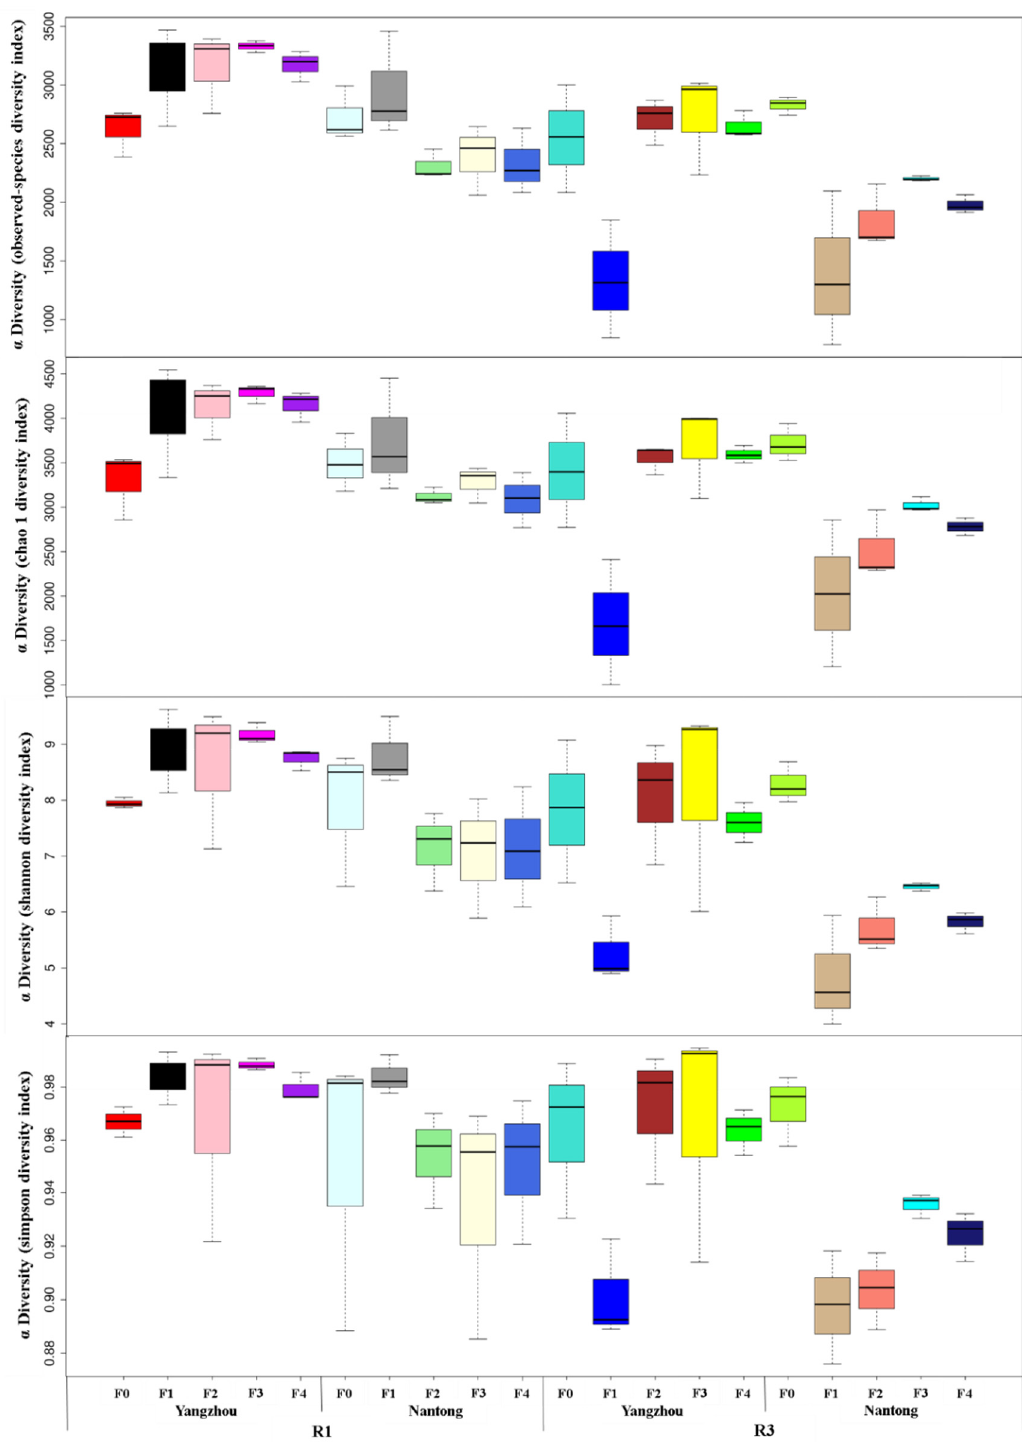
Figure 1. Grouped box plot of α diversity index for rhizosphere soil of different fertilization treat- ments. F0, no fertilizer; F1, F2, and F3 represent new compound fertilizer applied 225 kg N ha − 1 at sowing, V3, and V6 stages, respectively; F4: applied 75 kg N ha − 1 traditional compound fertilizer at sowing stage and 150 kg N ha − 1 urea at V6; R1 and R3 represent silking and milking stages. In each Panel, the abscissa is the grouping label, and the ordinate is the value of the corresponding α diver- sity index.